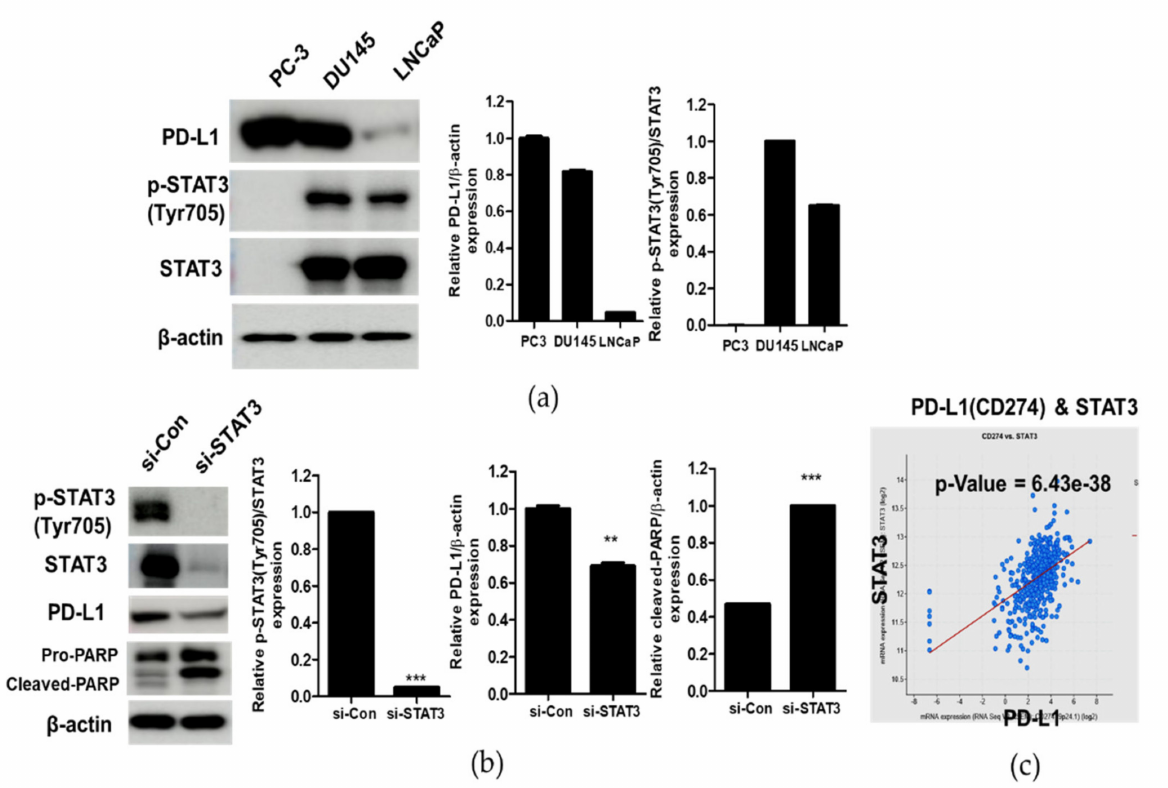
Figure 2. Correlation between STAT and PD-L1 in DU145, PC3 and LNCaP prostate cancer cells. ( a ) Endogenous expression levels of PD-L1 and p-STAT3 in PC3, DU145 and LNCaP prostate cancer cells. The expression levels of p-STAT3, STAT3 and PD-L1 in PC3, DU145 and LNCaP cells by Western blotting using anti-p-STAT3, STAT3 and PD-L1 antibodies. ( b ) Effect of STAT3 depletion on pro-PARP, cleaved-PARP and PD-L1 in DU145 cells. Cell lysates were prepared and subjected to Western blotting for p-STAT3, STAT3, PD-L1 and PARP. ( c ) cBioportal database shows the correlation between STAT3 and PD-L1. Graphs represent relative levels of protein/ β -actin. Data represent means ± SD. ** p < 0.01 and *** p < 0.001 versus